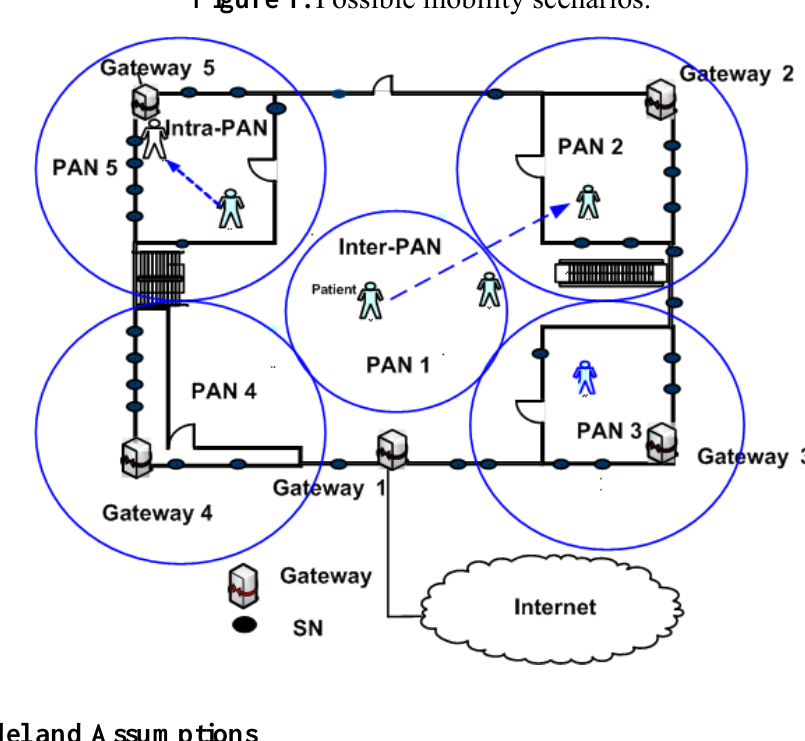
Figure 1. Possible mobility